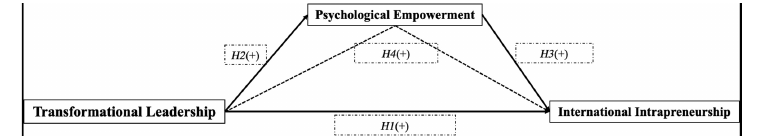
Figure 1. Conceptual